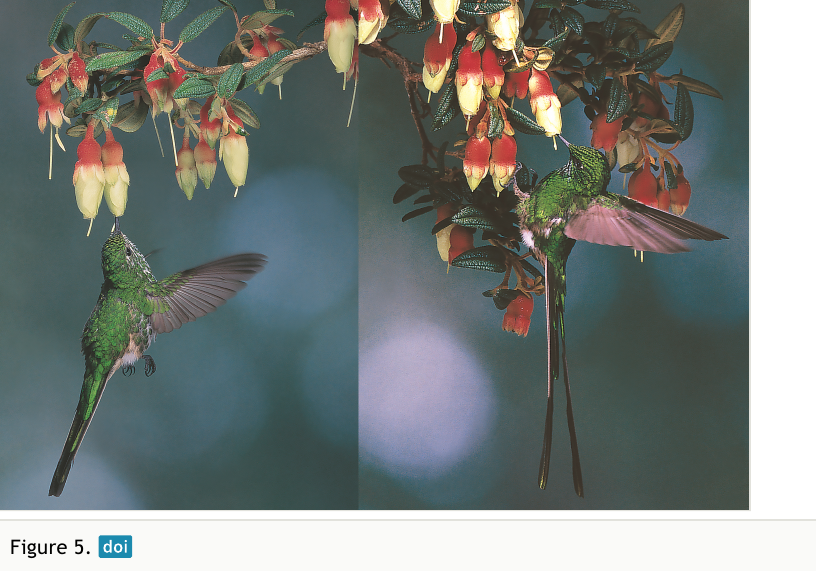
Female (left) and male (right) Green-tailed Trainbearers ( Lesbia nuna ), from Volcan Pichincha, Ecuador. Photos: Dr. Luis